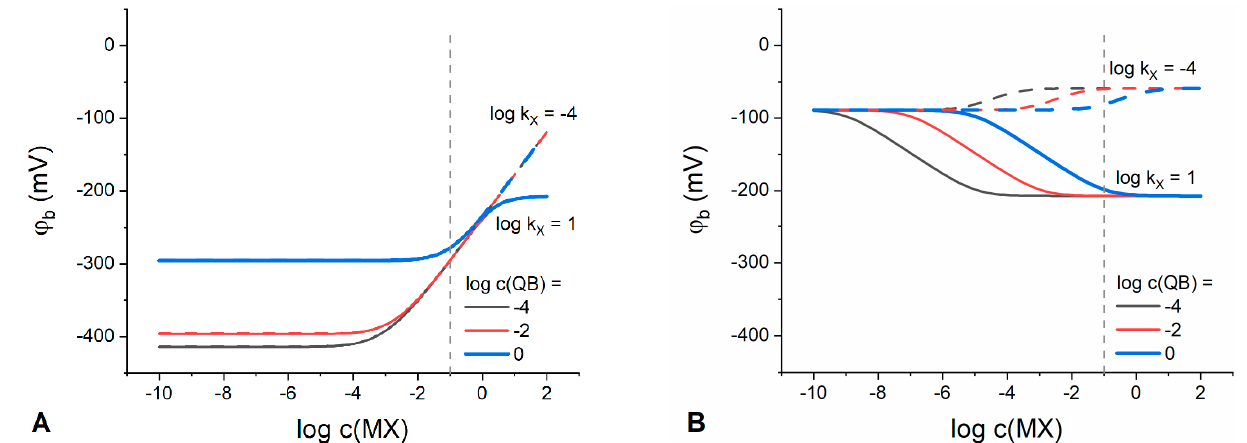
Figure 6. Phase boundary potential simulated vs. MX concentration in the aqueous phase at different Q + B − concentrations in the polymeric phase (indicated in the plot) at varied lipophilicity of anion X − (10 and 10 − 4 for solid and dotted lines, respectively): ( A ) c ( IR ) = 10 − 2 M; ( B ) no added IR electrolyte. k M = 10 − 6 ; k Q = 10 6 , k B = 10 9 ; k I = 10 − 5 , k R = 10 9